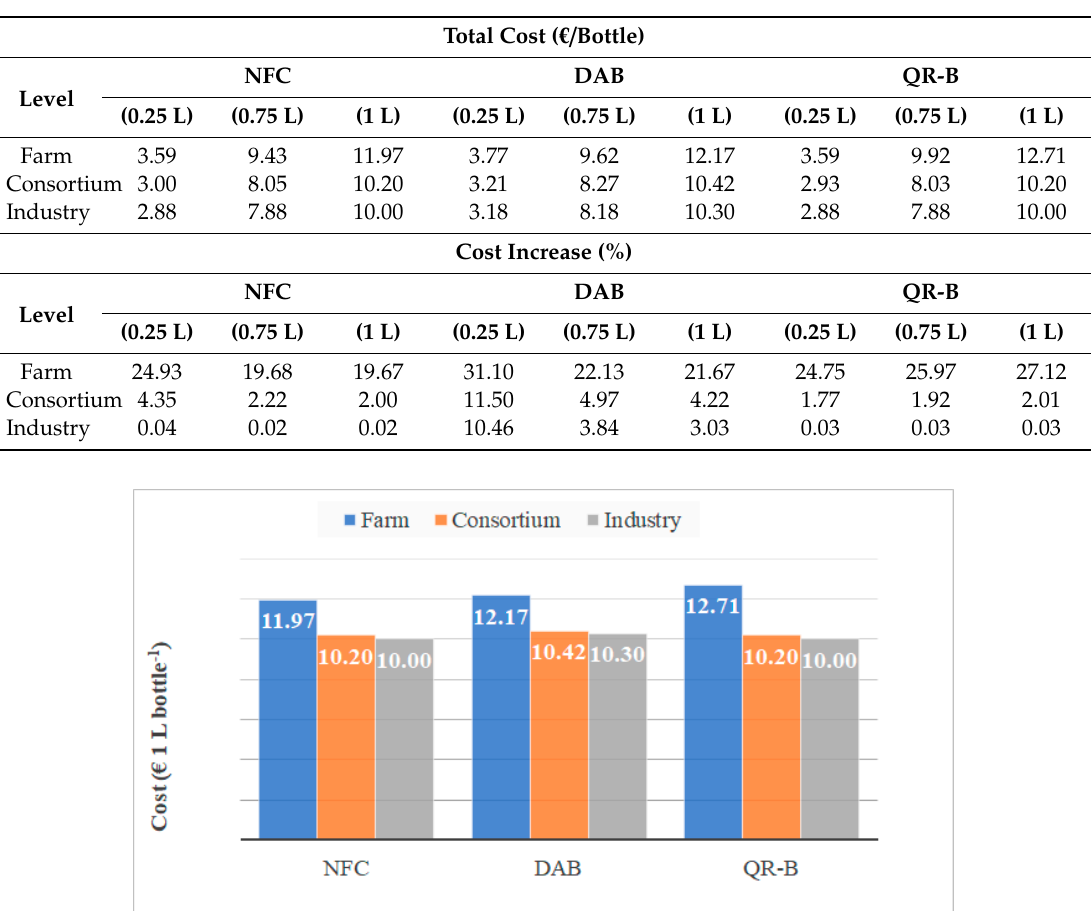
Figure 1. Final cost of the bottle (1 L) including additional costs due to the application of the three technologies for the three production levels (initial price equal to 10 € bottle − 1 ). NFC: Near Field Communication; DAB: Dispositivo Antimanomissione per Bottiglie; QR-B: Quick Response Blockchain.